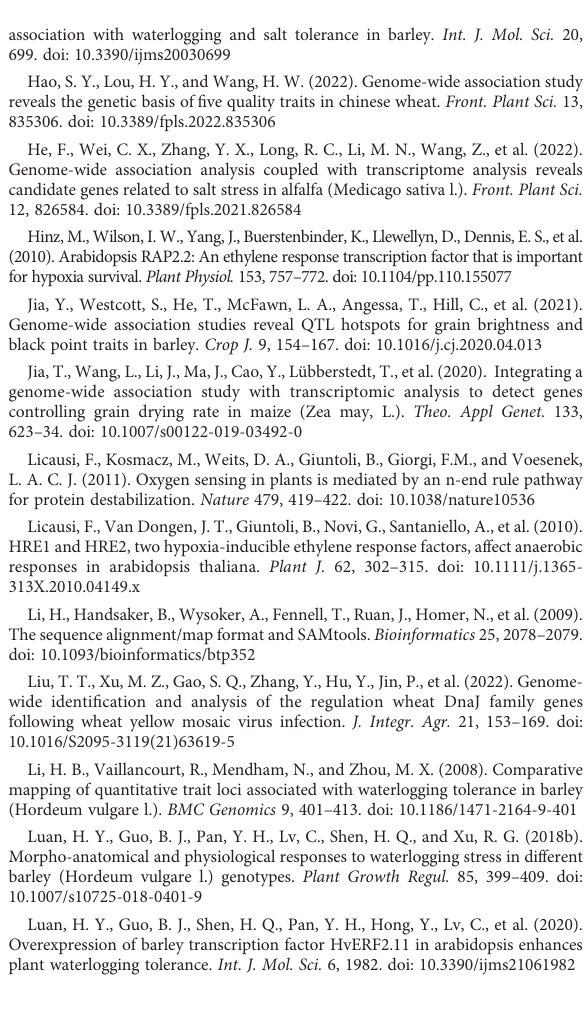
horizontal axis shows chromosome length (Mb); the different colors depict SNP density (the number of SNPs per window).